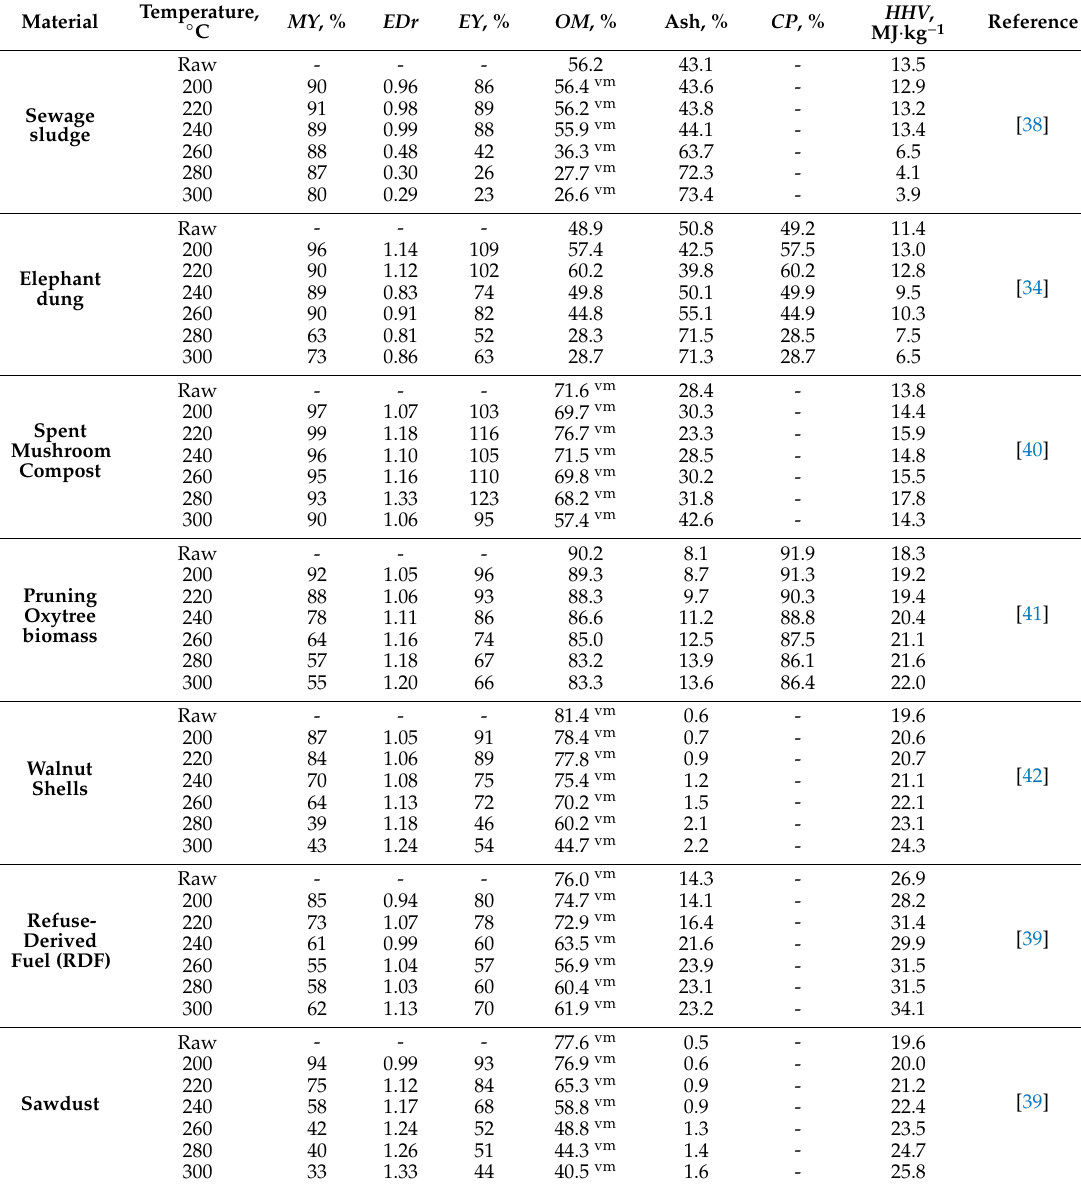
Table 3. Summarized results of the torrefaction process technological parameters for di ff erent waste materials (process time = 1